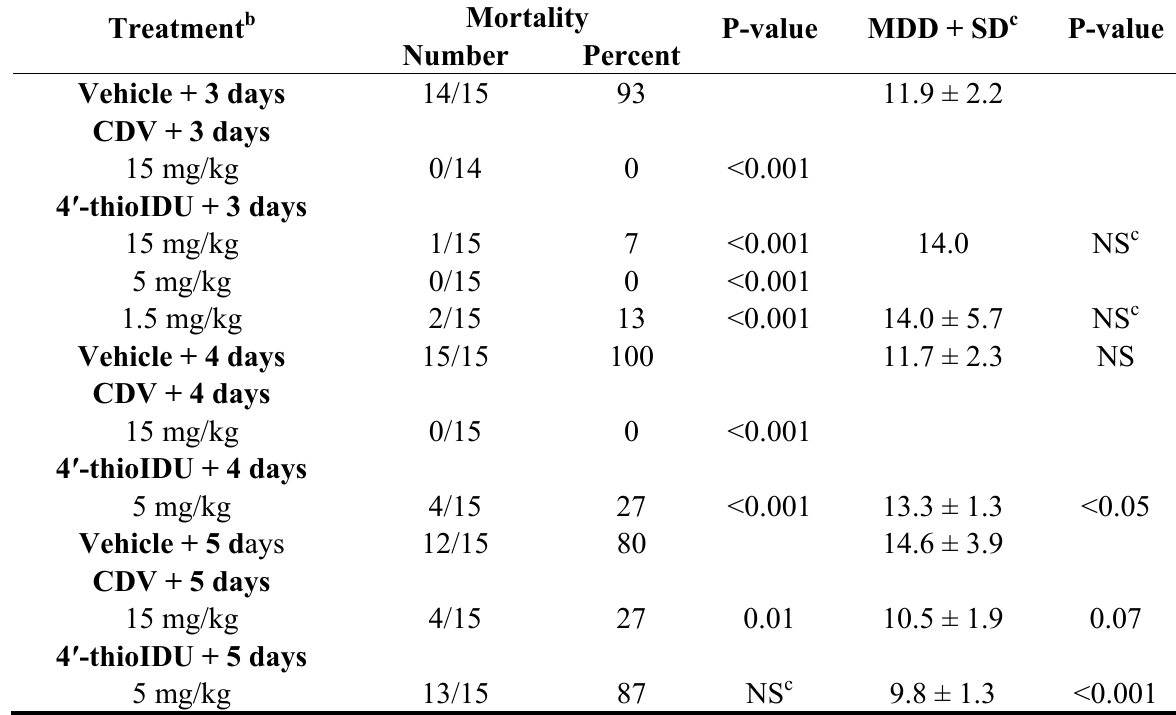
Table 3. Effect of oral treatment with 4 ′ -thioIDU on mortality of BALB/c mice inoculated intranasally with Cowpox Virus a